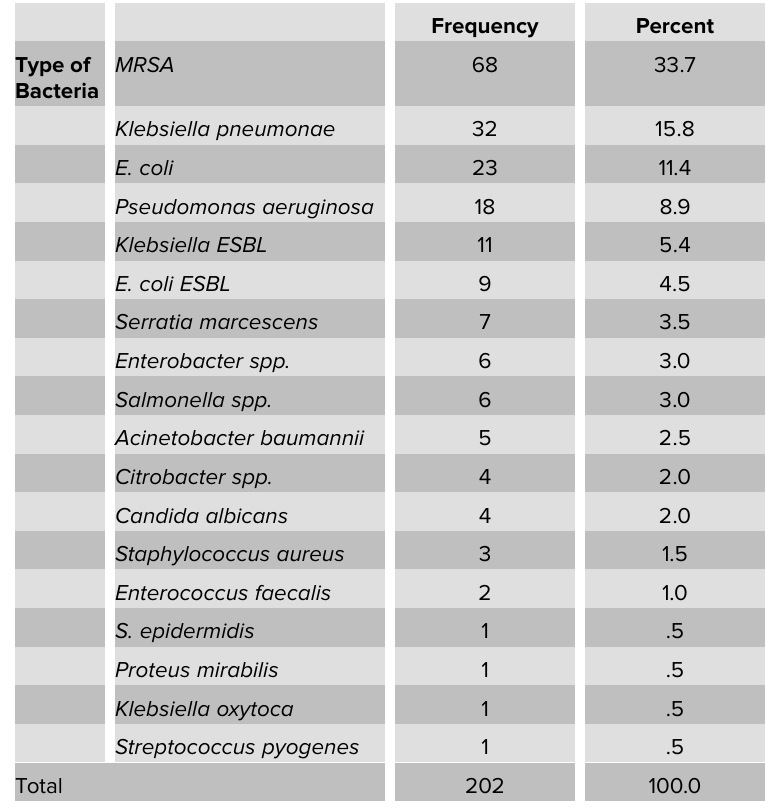
Table 2: Frequencies of bacteria that cause neonatal sepsis in which MRSA is the most common organism ( n = 202).